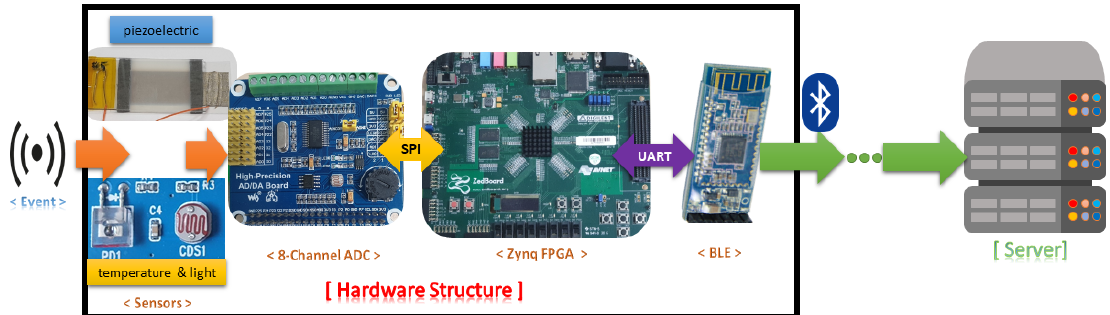
Figure 1. System block